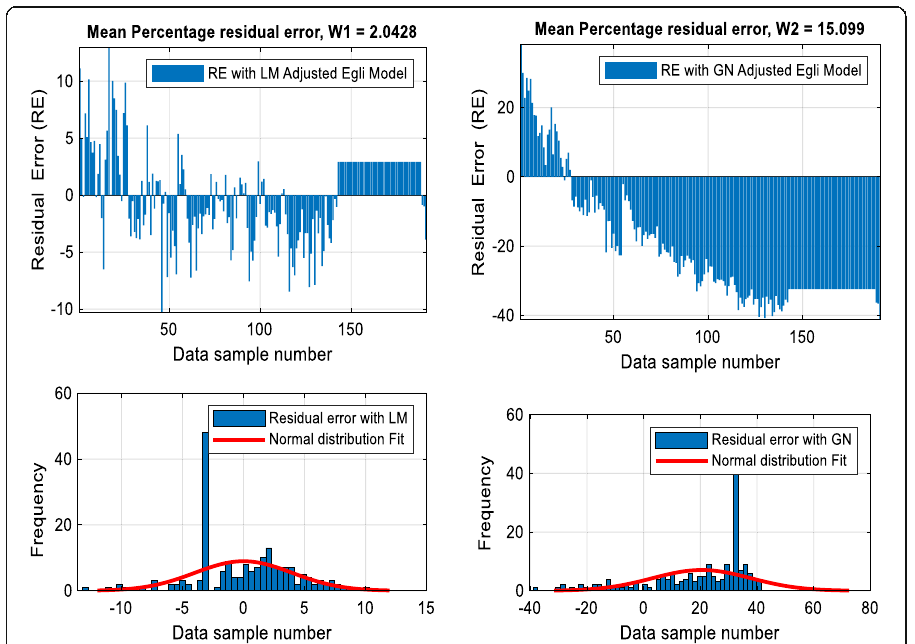
Fig. 11 Measured propagation loss estimation and their error distribution statistics using classical Egli model and adapted Egli model for